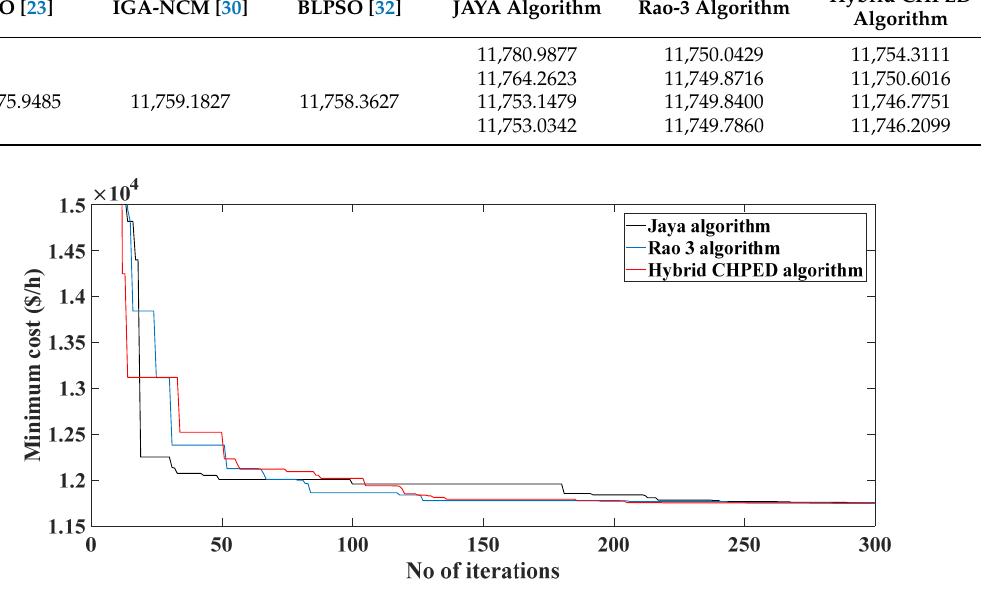
Figure 3. Minimum price convergence curve for the 5-unit test system.